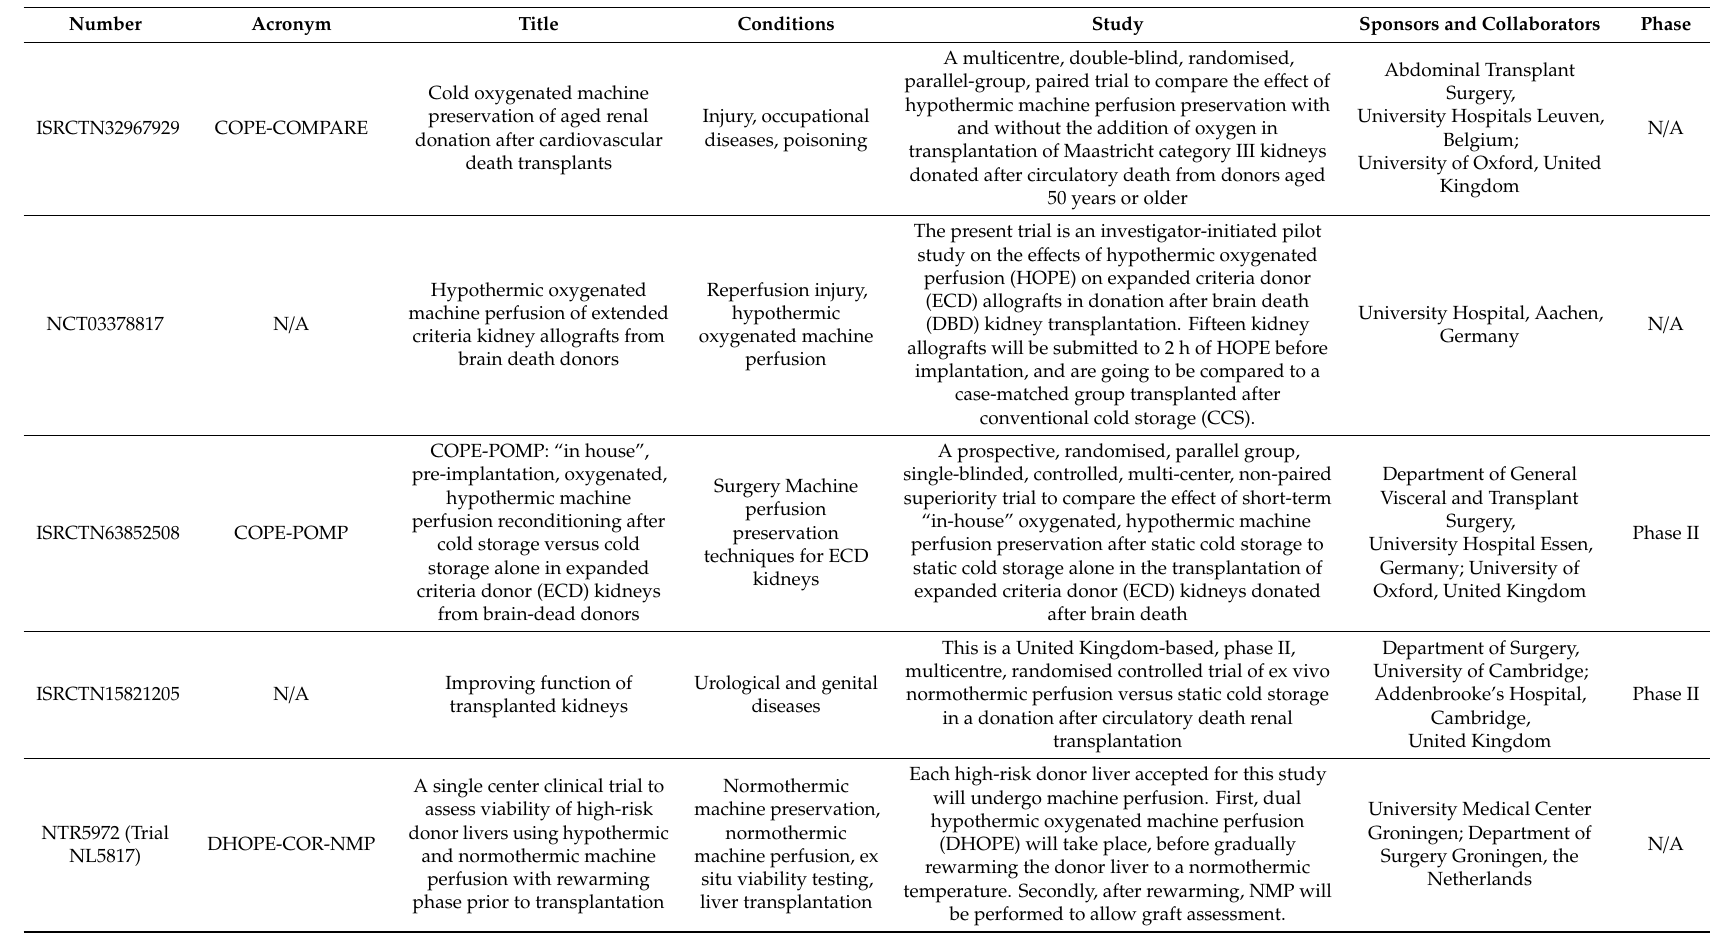
Table 1. Ongoing clinical trials with non-published